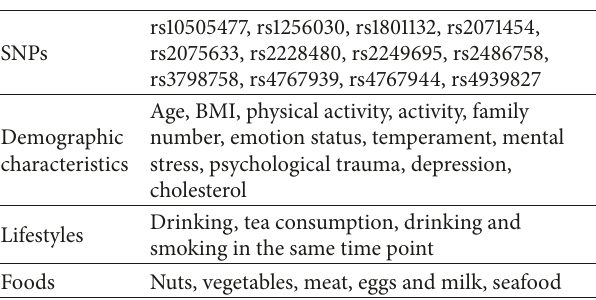
Table 2: The results by SPCA method.